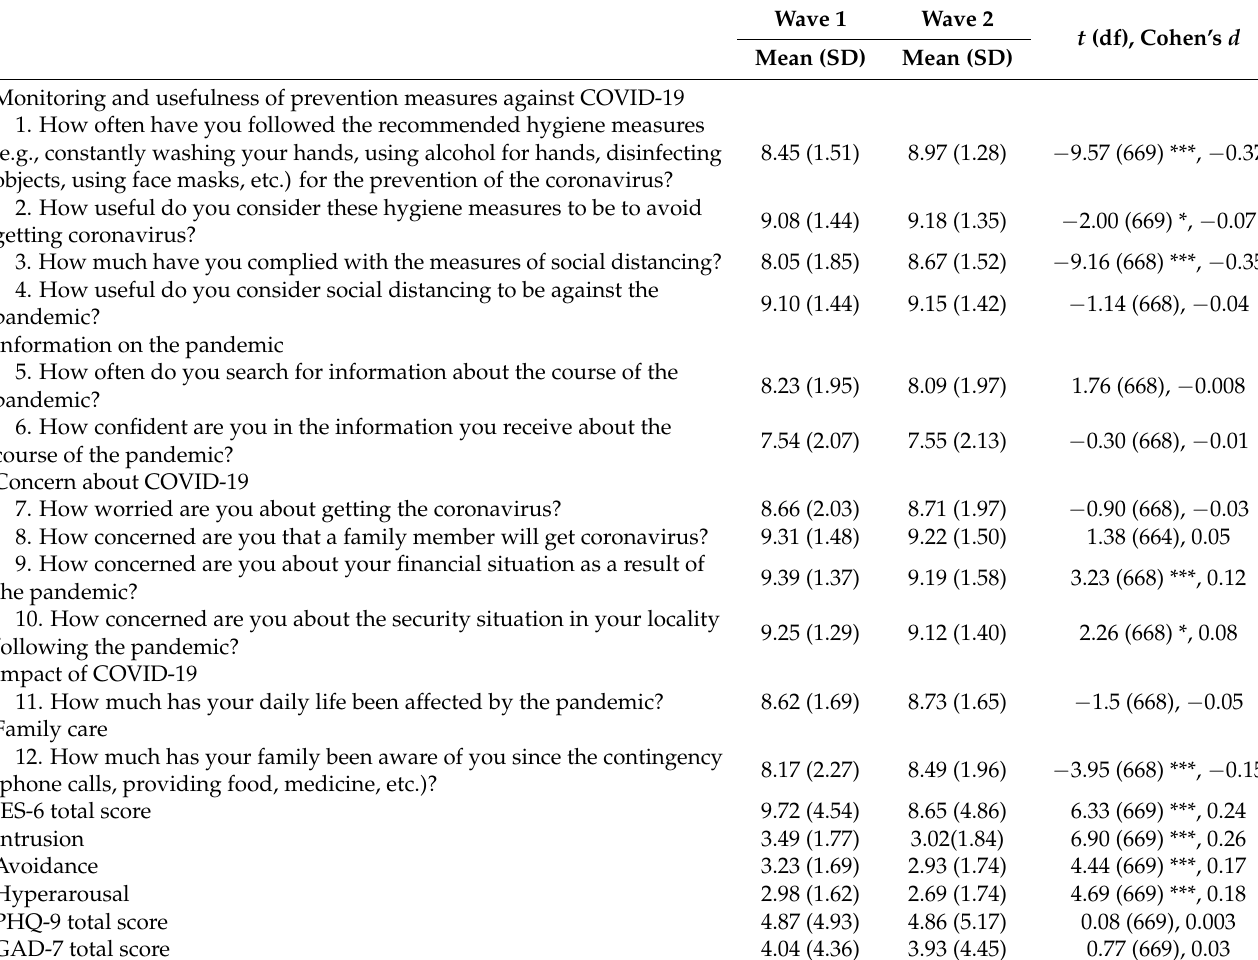
Table 1. Differences for concerns and behaviors related to COVID-19, distress, depression, and anxiety (N = 670).